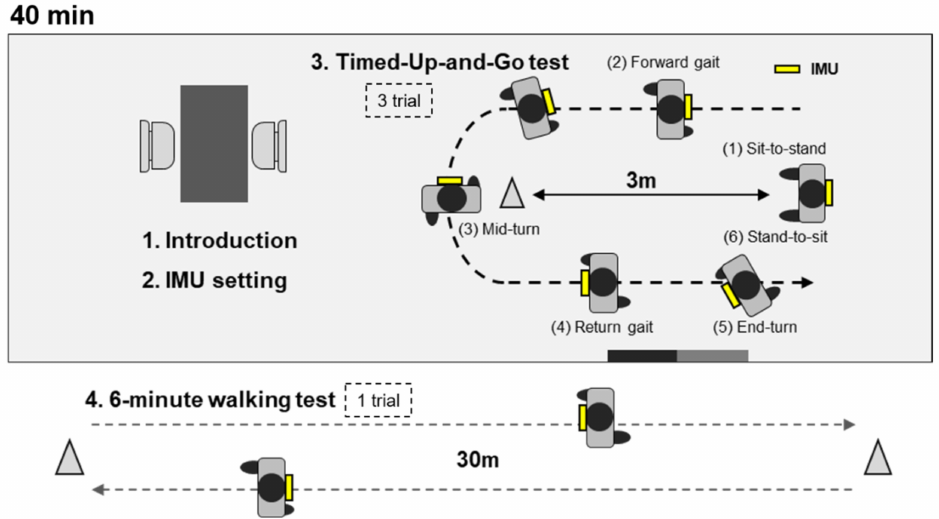
Figure 2. Data collection procedure and